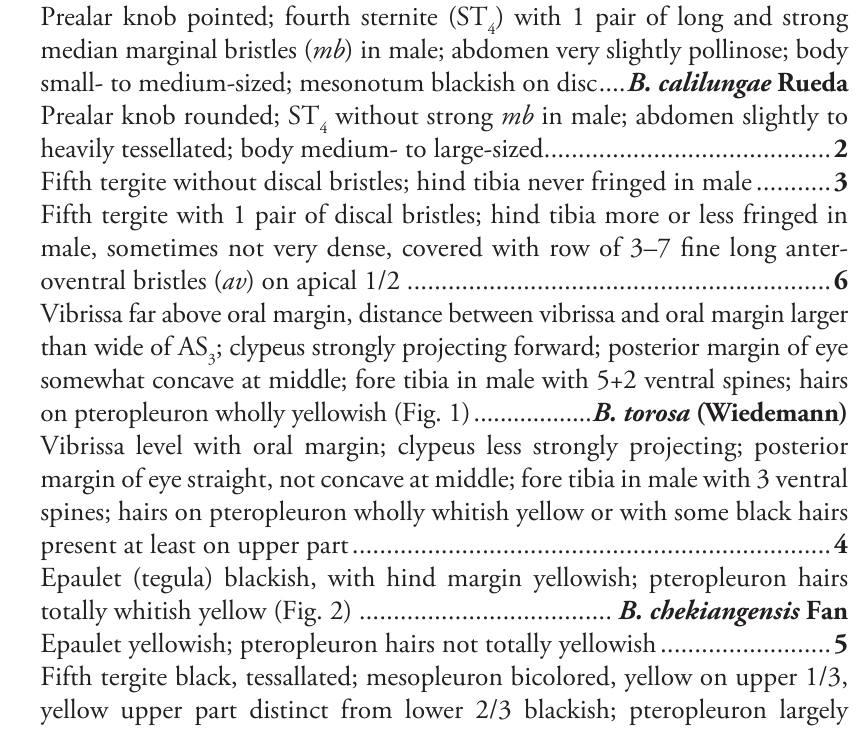
– First postsutural ac normal, on anterior 3/5 part of postsutural area; distance between first postsutural dc and second postsutural dc as long as distance be- tween second postsutural dc and third postsutural dc .................................. 7 Alar squama (upper calypter) creamy, with tuft of yellowish white hairs at inner lower margin; thoracic squama pale, brownish on disc ............ L. bazini Séguy – Alar squama fuscous brown, sometimes more or less paler at inner 1/2, but usually with tuft of blackish-brown, sometimes brown, hairs at inner lower 8 Posterior surface of postgena clothed with yellow hairs; parafacilia narrow, invisible in profile, about 1/2–2/3 of the width of AS , golden yellow dusted, 3 often darkened above ........................................................ L. calviceps Bezzi – Posterior surface of postgena clothed with black hairs; parafacilia rather broad, at least as broad as the width of AS , gray dusted, rarely with yellow 3